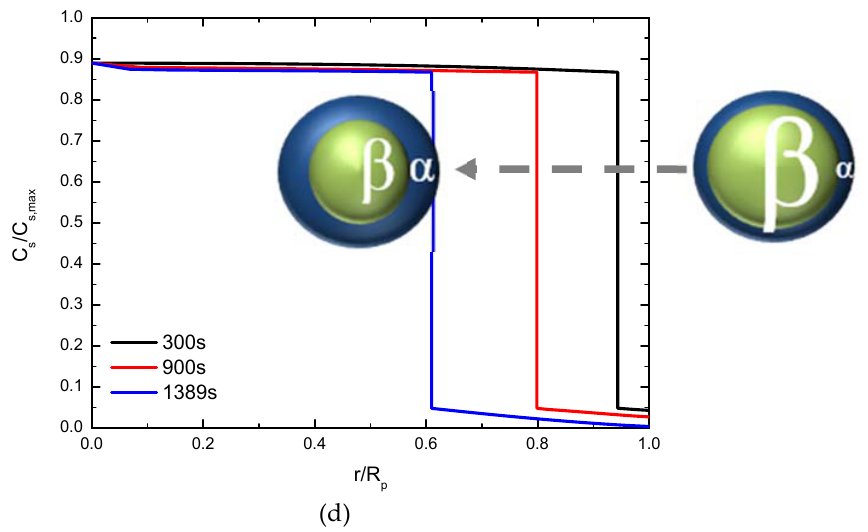
Figure 7. ( a ) Evolution of the two ‐ phase interface between the α and β phases in LFP particles, and dimensionless lithium ion concentration profiles for ( b ) 0. 5C charge, ( c ) 1 C charge, and ( d ) 2 C charge. The above simulation results were taken at the LFP particle located in the center of the electrode (x = 119 μ m, y = 0.5 cm, z = 0.5 cm).